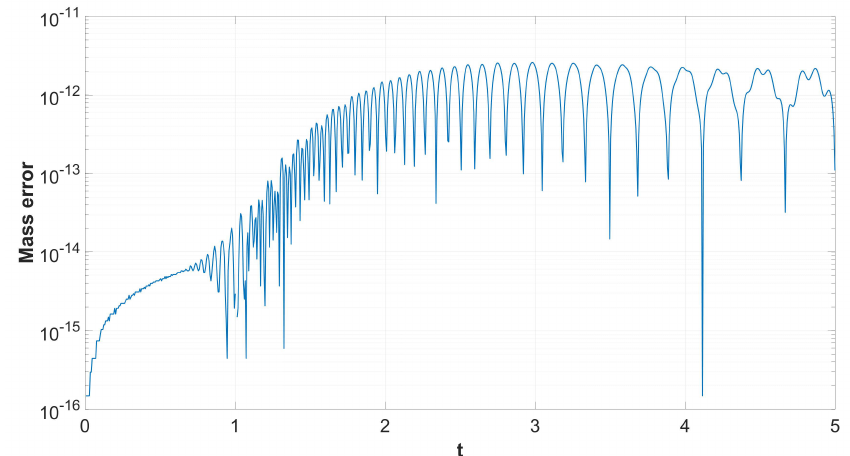
Figure 15. The mass error versus t with the use of finite difference schemes for the spatial semi-